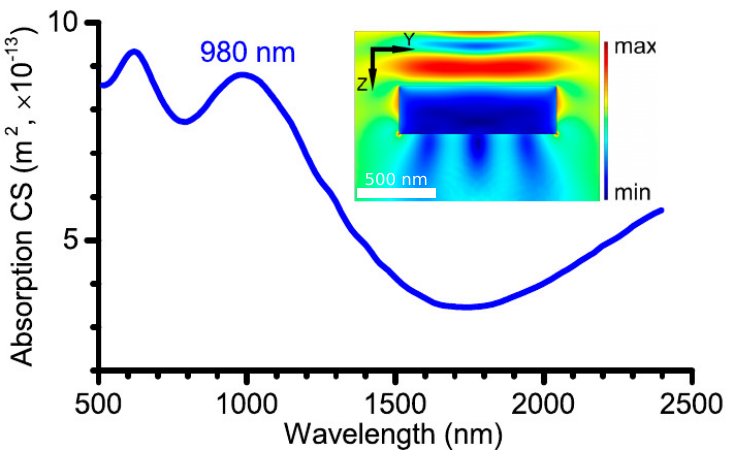
Figure 3. Simulated absorption CS of Ti 3 C 2 T x cylinder of diameter 1000 nm with height 300 nm. Inset: electric field intensity map at the wavelength of QSP resonance—980